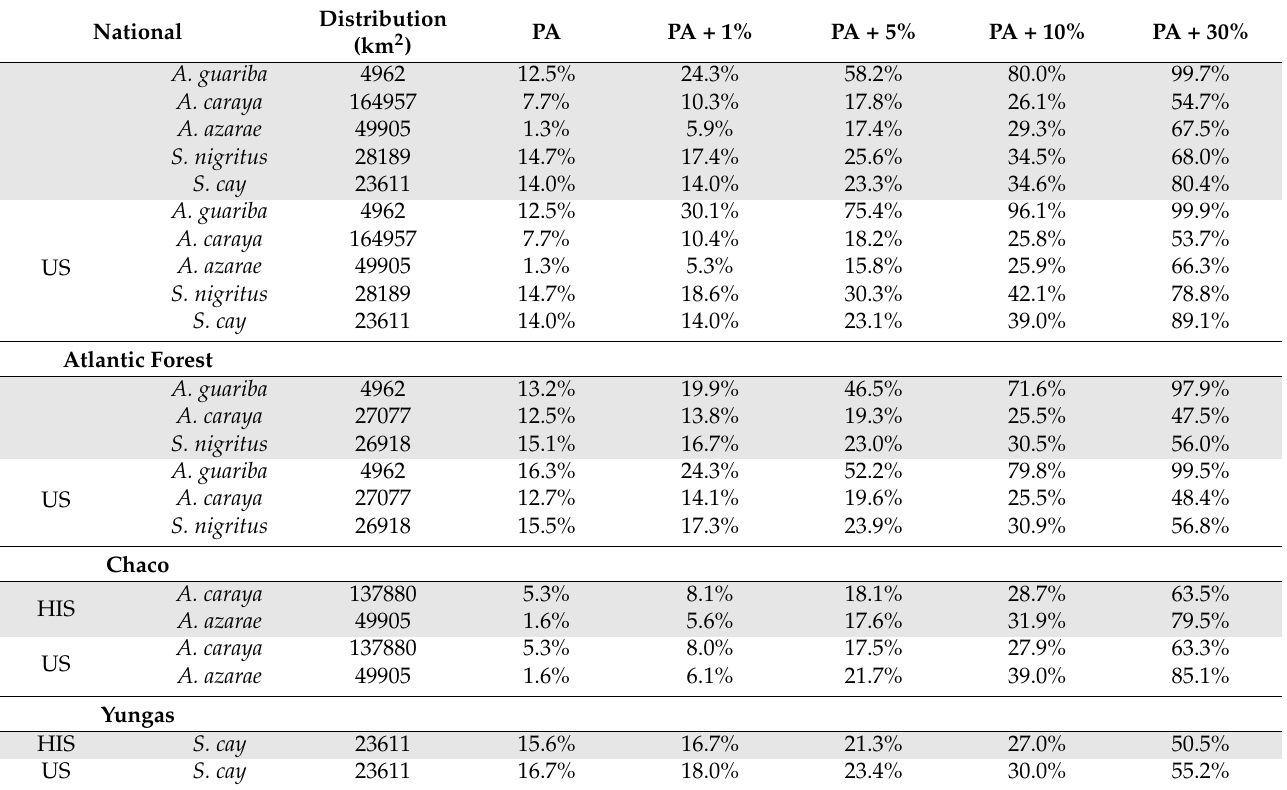
Table 1. Percentages of each primate species’ distribution range represented in the protected areas (PA) and within the priority areas according to the different conservation targets (PA + 1%, PA + 5%, PA + 10%, PA + 30%). Values are provided for both scenarios, with a human footprint (human- influence scenario—HIS, in gray) and without a human footprint (unconstrained scenario-US), at national and ecoregional